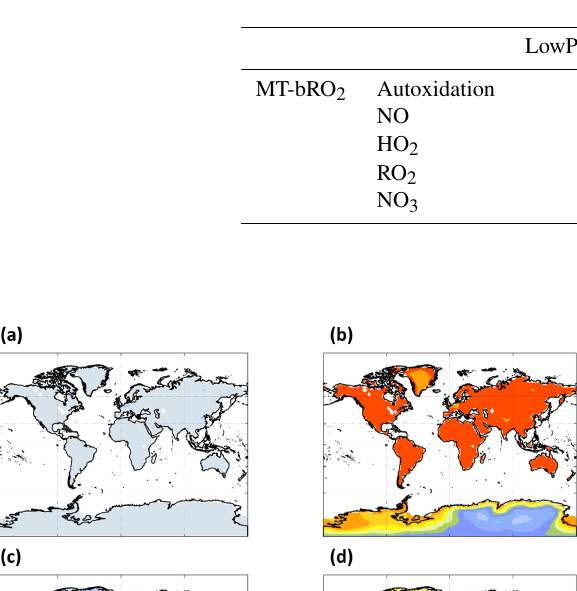
Table 2. Global PBL-averaged MT-bRO 2 fates weighted by gridded MT-bRO 2 concentrations on land.